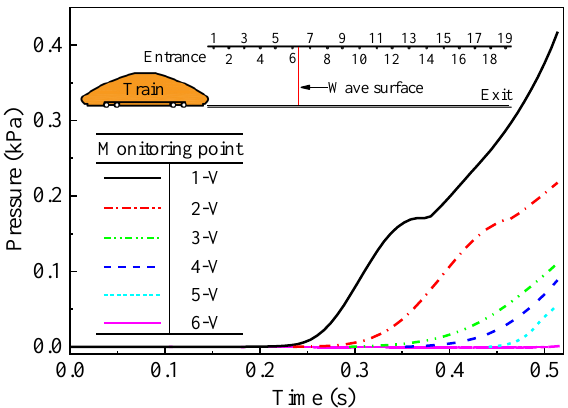
Figure 12. Time histories of aerodynamic pressure of typical monitoring points in Stage I ( v = 350 km/h).